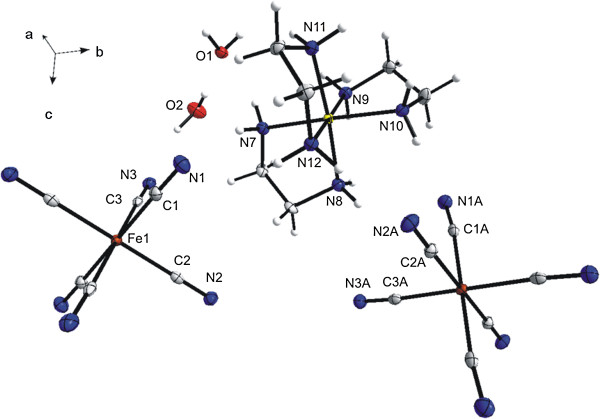
Molecular structure of [Co( en )3][Fe(CN)6]⋅ 2H2O (1a). The thermal ellipsoids are drawn at the 50% probability level.